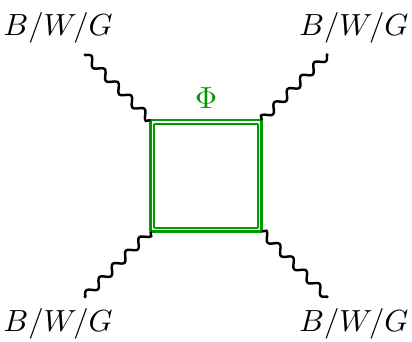
Figure 4 . One-loop diagram involving a heavy state (cid:8), which when integrated out will generate a set of CP-even F 4 operators, the coe(cid:14)cients of which must obey our bounds. Here (cid:8) can be a complex scalar, Dirac fermion, or complex vector